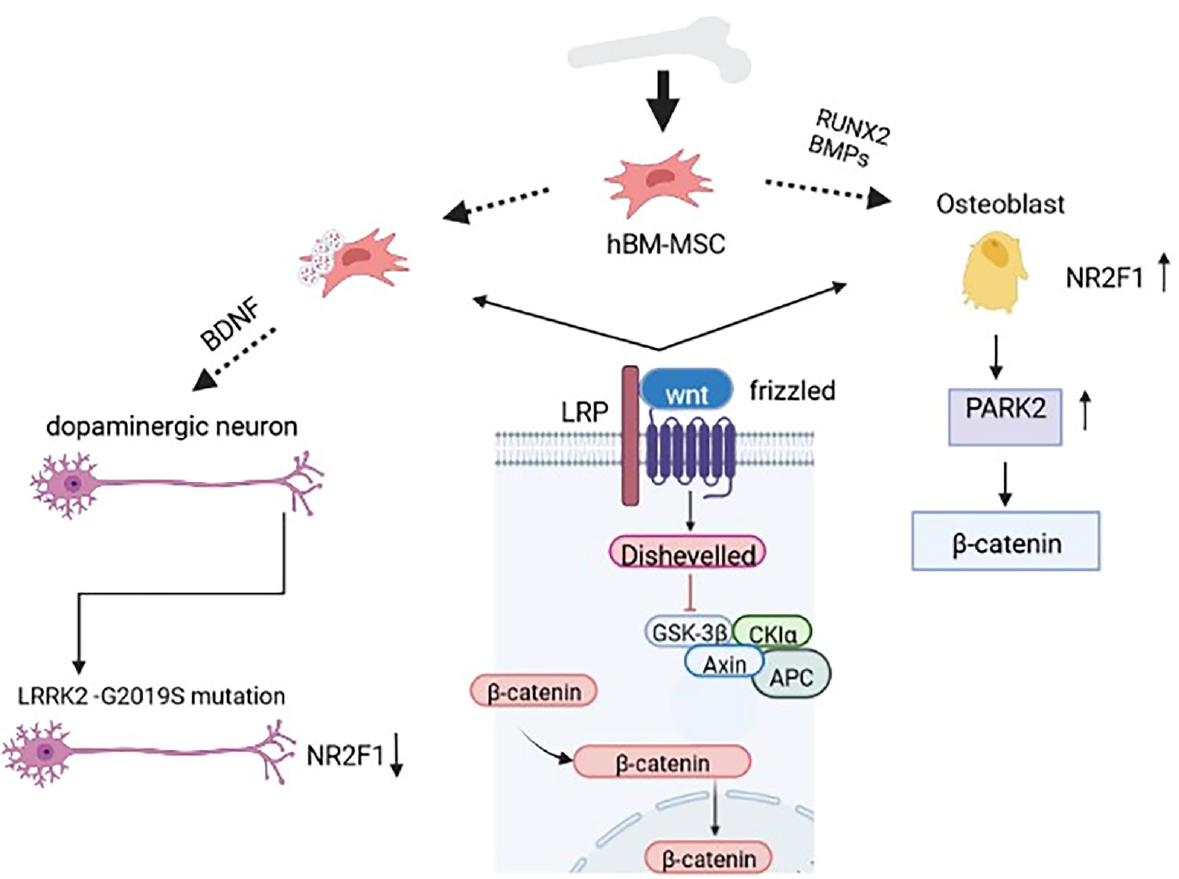
Figure 1. Bone morphogenetic proteins (BMPs) and the master gene of the osteoblastic commitment, RUNX2, play an important role in osteogenic differentiation. Further, the secretion of neuronal growth factors promotes neuronal commitment. Wnt/ β -catenin signaling is a common pathway of these two different lines. In particular, for osteoblastic commitment, an increase in Park2 stimulates the activation of β -catenin. The expression of NR2F1 is downregulated in the DA neuron of PD patients carrying the LRRK2-G2019S mutation.